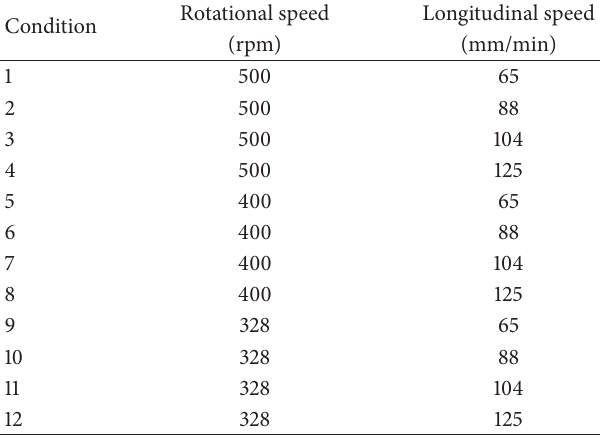
Table 1: Chemical composition of AA-5083-O. Table 2: Conditions to process preliminary